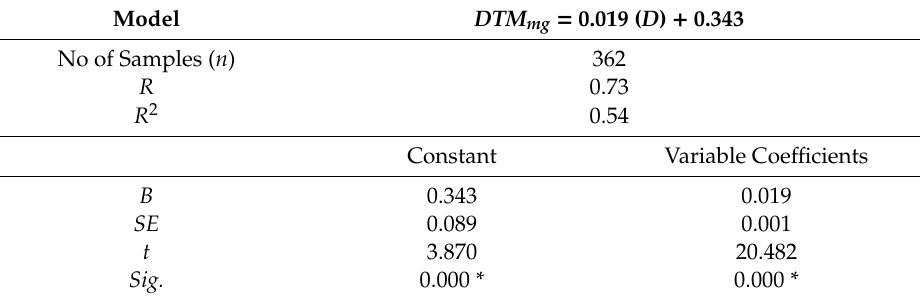
Table 3. Regression Statistics of the Digital Terrain Model (DTM) Estimation Model.